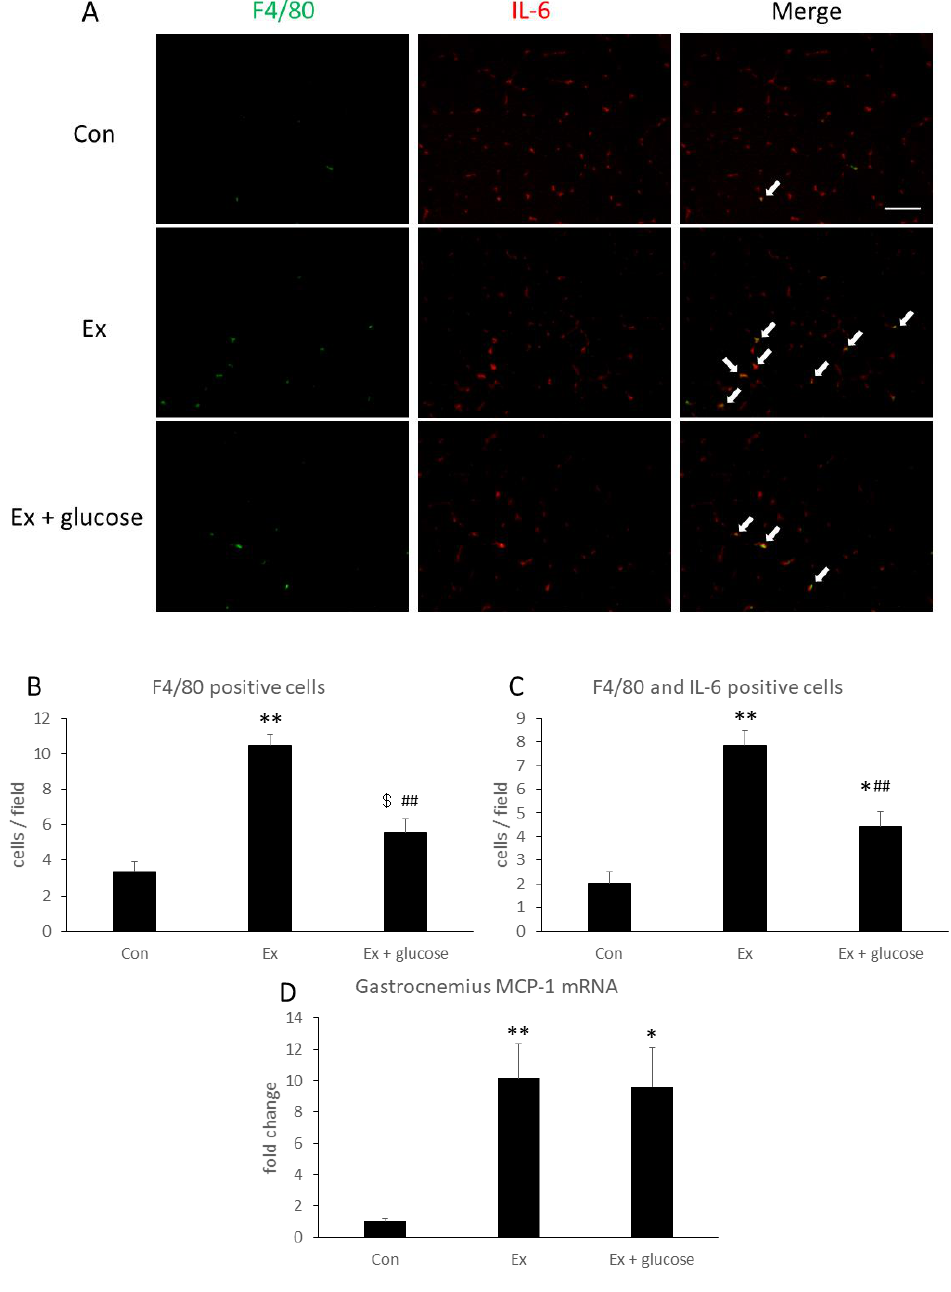
Figure 4. Effects of exercise and glucose ingestion on macrophage infiltration in gastrocnemius. ( A ) Localization of F4/80 [green] and IL-6 [red] of gastrocnemius detected by immunofluorescence staining. Arrows indicate F4/80 and IL-6 double positive cells. Scale bar is 100 µm. ( B ) The number of F4/80 positive cells and ( C ) the number of F4/80 and IL-6 double positive cells. ( D ) Monocyte chemotactic protein (MCP)-1 mRNA expression in gastrocnemius. The data are presented as means ± SE. * p < 0.05, ** p < 0.01 compared to Con. ## p < 0.01, $ p = 0.086 compared to Ex.